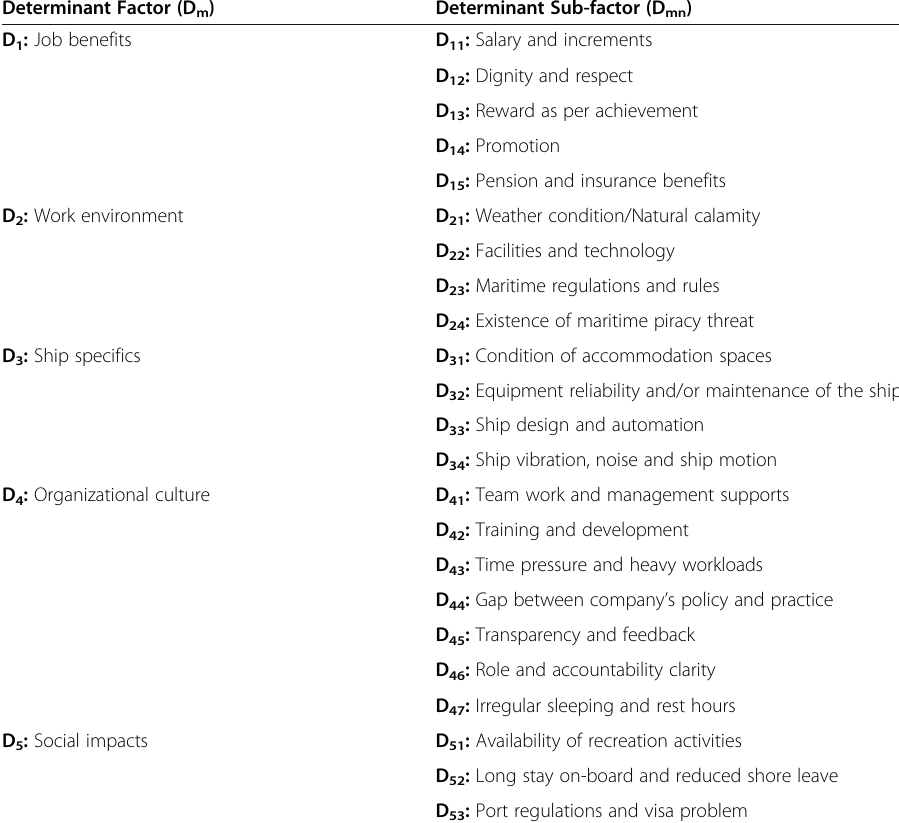
Table 2 Determinants of work place performance for seafarers Determinant Factor (D m